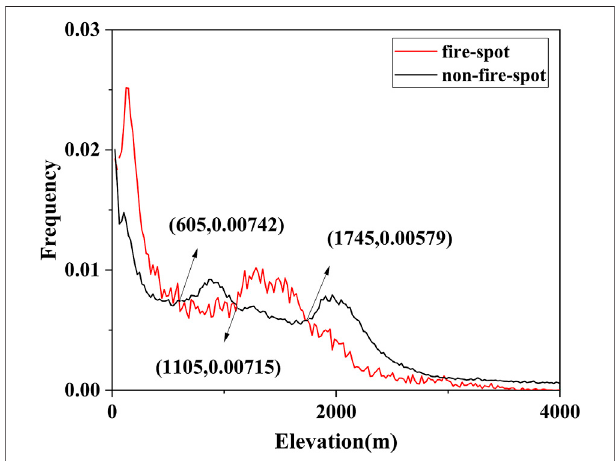
FIGURE 2 | The frequency distribution of